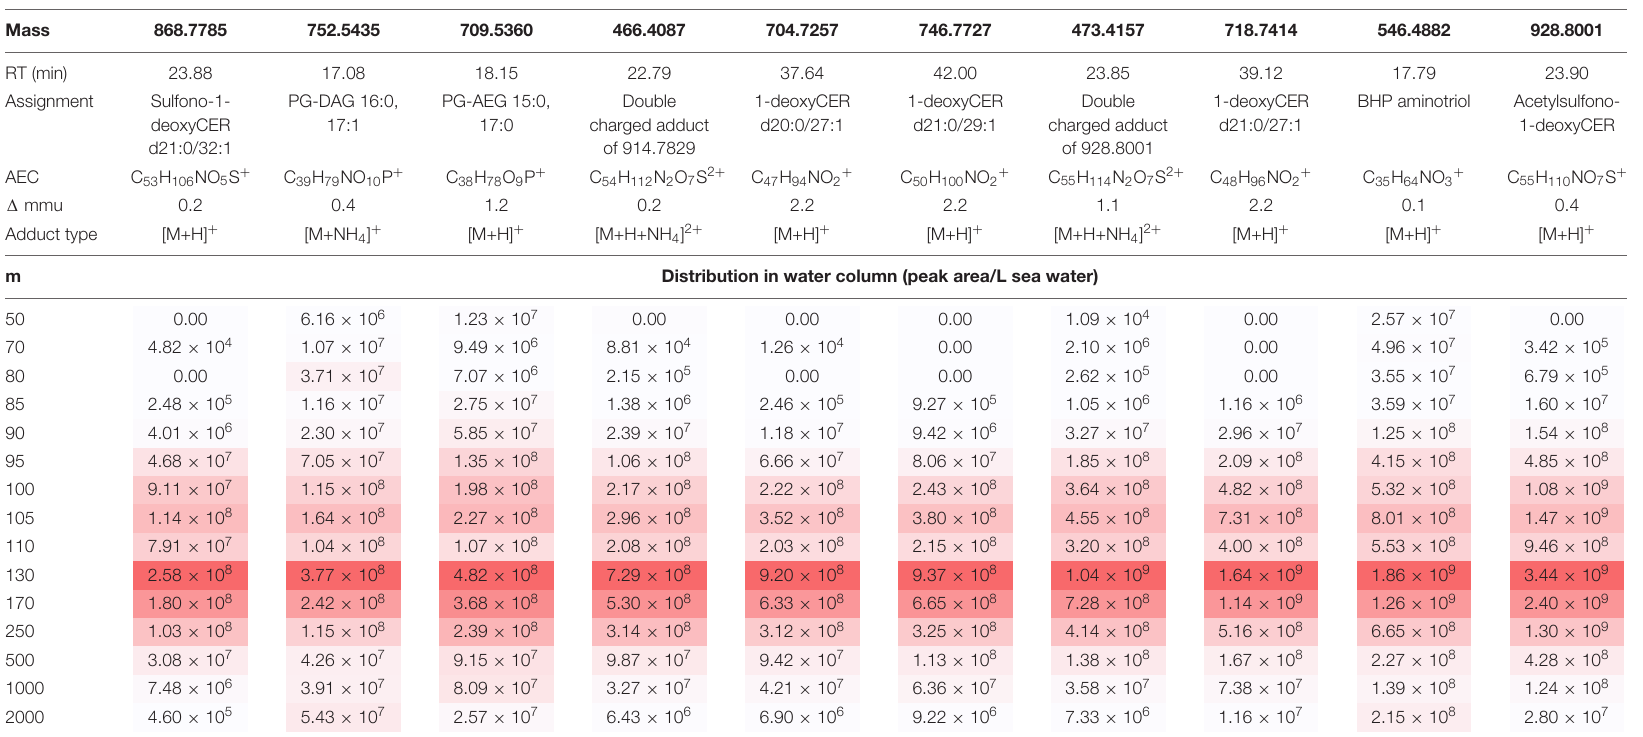
TABLE 3 | The most abundant components of cluster Dx in the Black Sea SPM extracts (2013